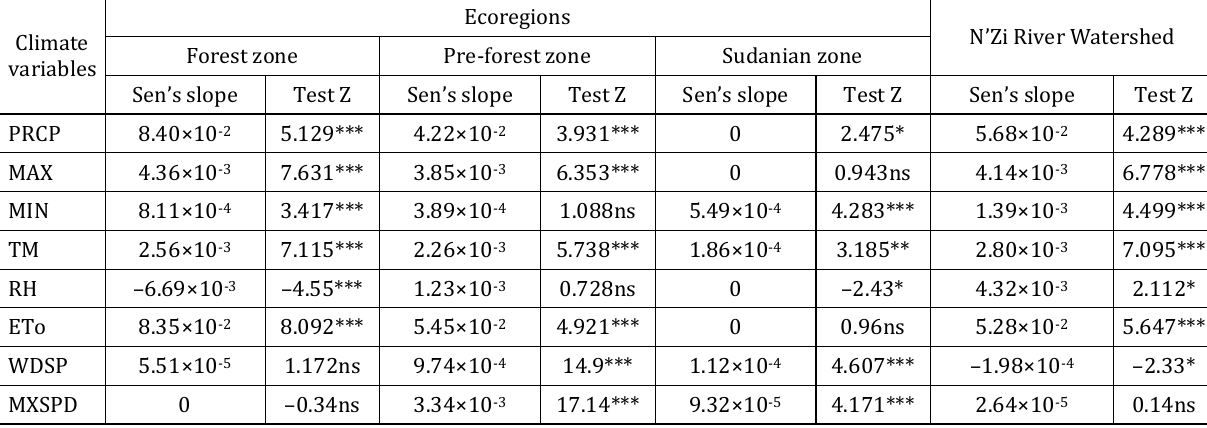
Table 1. Trends in climate series in the different ecoregions of the N’Zi River Watershed Climate